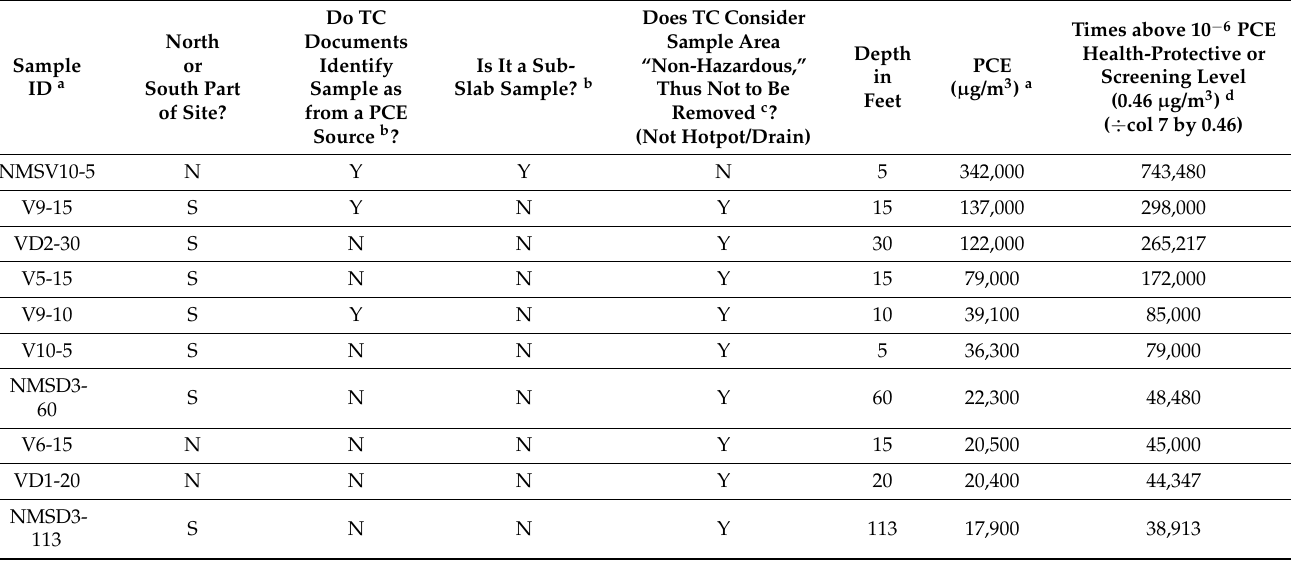
Table 1. Highest of 172 known-soil-gas-VOC-violation locationsa for per/tetrachloroethylene (PCE), single or temporary-well samples, NOTSPA, Pasadena, California.